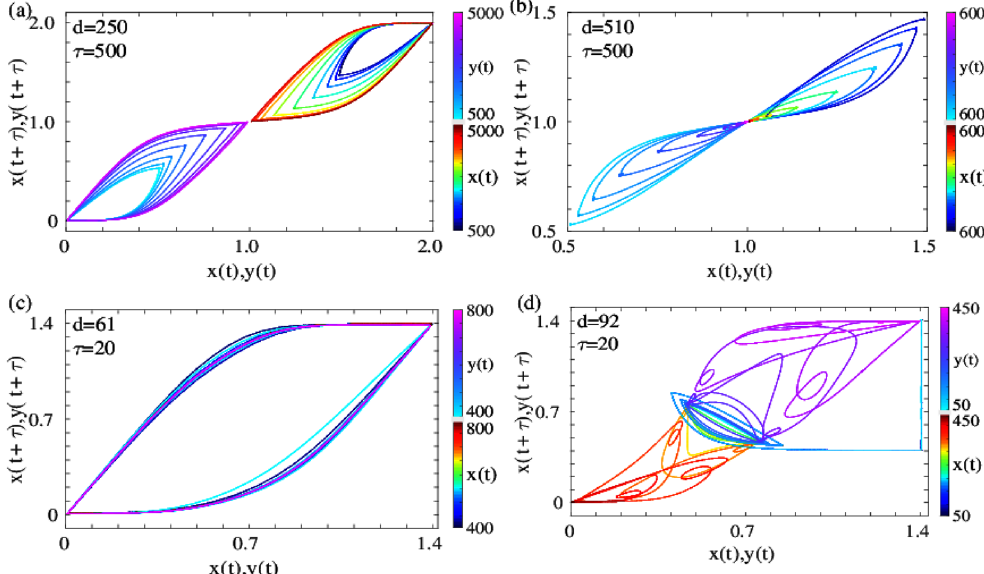
Figure 6. Trajectory plots in the x / y ( t ) vs. x / y ( t + τ ) plane for ( a ) Oscillatory state in regime A (state IIA ). The oscillations are between the differentiated states and the central undifferentiated state, which are represented as half-cycles in this phase plane. ( b ) Reprogramming to the undifferentiated state in regime A (state III ). Note the decaying transient oscillations in both x and y , which converge to the central steady state. ( c ) Oscillatory state in regime B (state IIB ). The oscillations are between the two differentiated states in this regime, which is represented by single limit cycle in this phase plane. ( d ) Transdifferentiated state in regime B (state IV ). Note the unstable oscillations around the central state preceding transdifferentiation. In all four cases, the trajectories are coloured by the time values, as shown in the corresponding